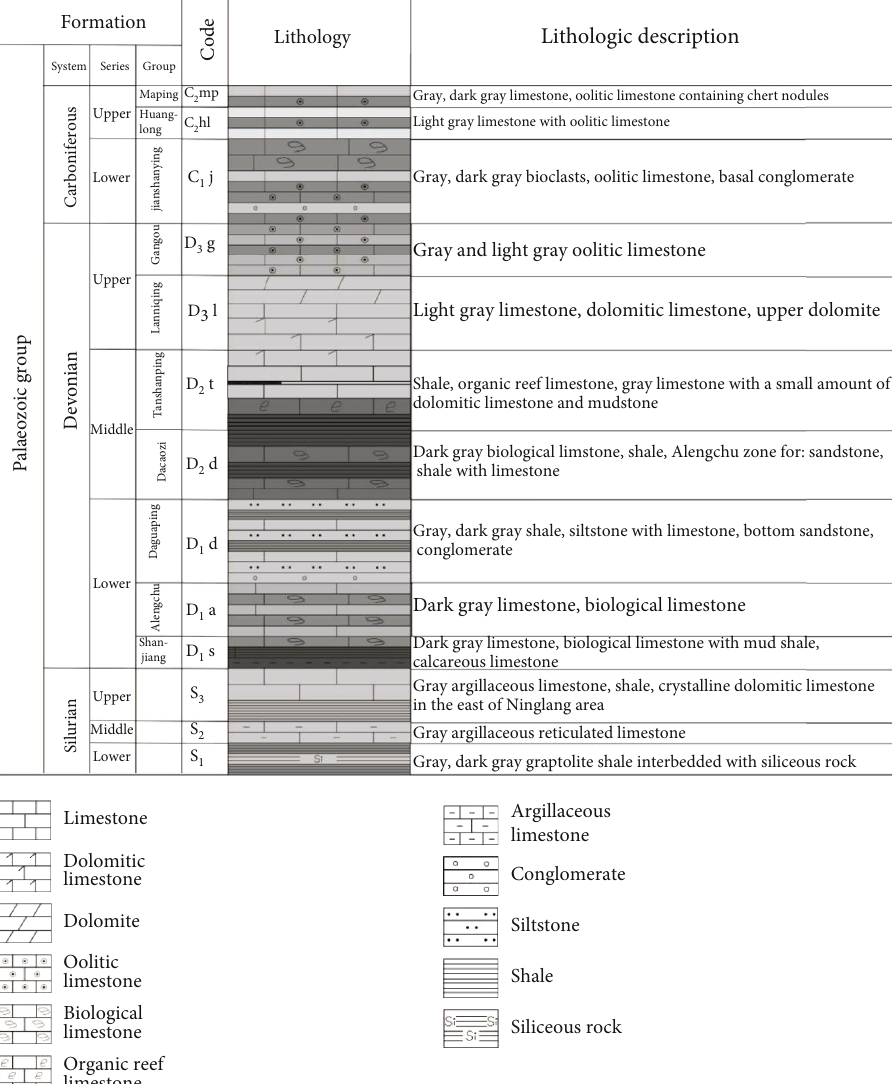
Figure 1: Comprehensive stratigraphic column of Devonian in Ninglang-Yanyuan